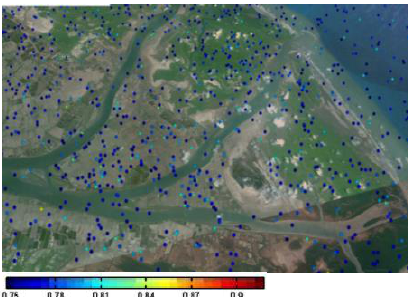
Figure 7: Coherence images overlaid on Google Earth